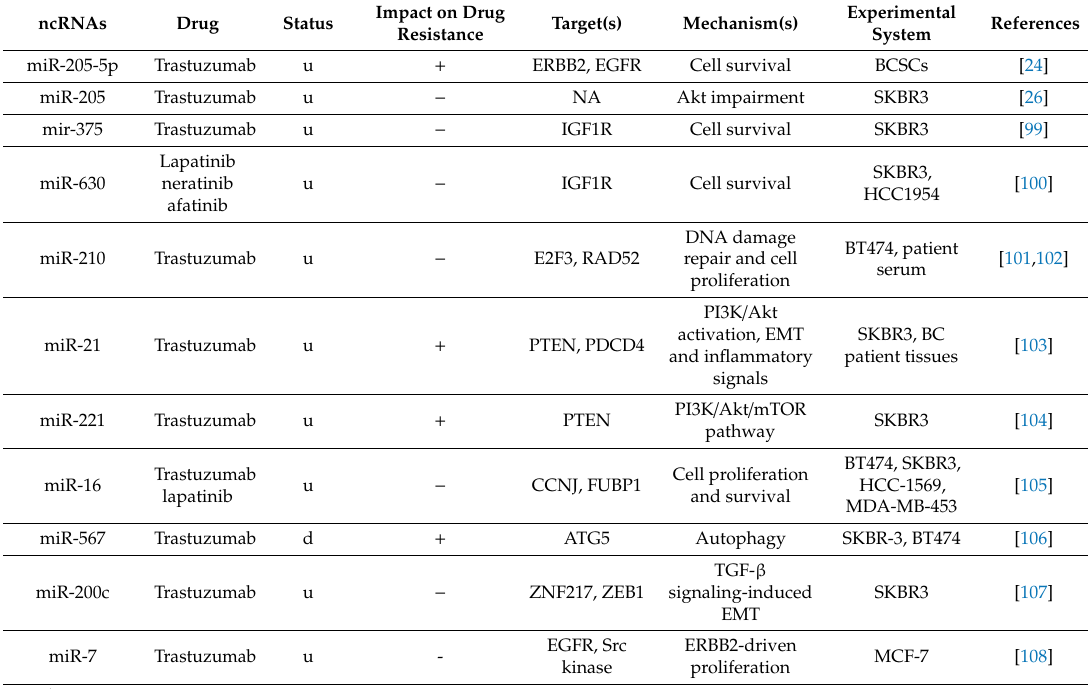
Table 2. miRNAs involved in targeted therapy resistance in BC 1 ; (u) upregulated; (d) downregulated; ( + ) increase; ( − )